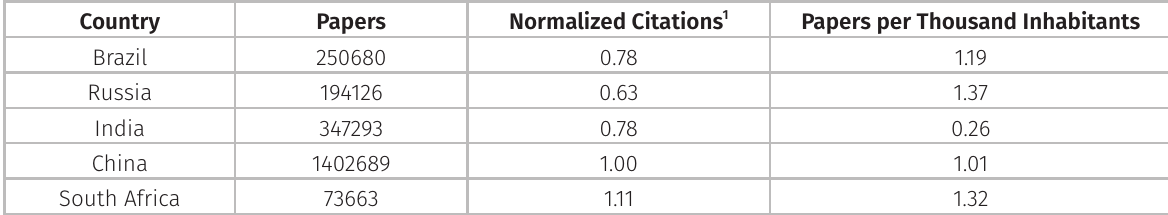
Table I. Papers published, citations normalized and papers per thousand inhabitants of brics countries, between 2011 and